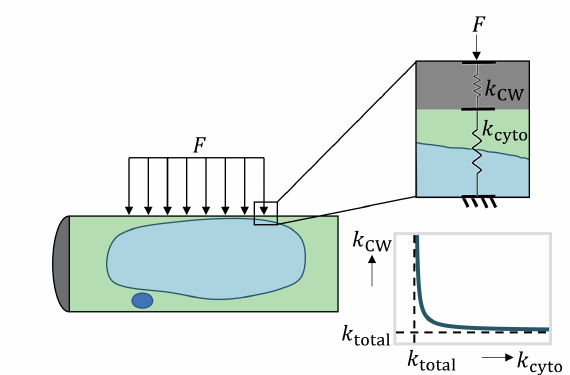
Figure 3. Proposed series spring model to analyze cell stiffness from micro-compression testing. The total stiffness measured by the micro-compression tool is the equivalent stiffness for the two springs in series, given by Equation (1), and it must be less than the intrinsic stiffness of either constituent spring in the series. For a given overall stiffness, k total , the included plot illustrates the relationship between the stiffness of the two springs, k CW and k cyto